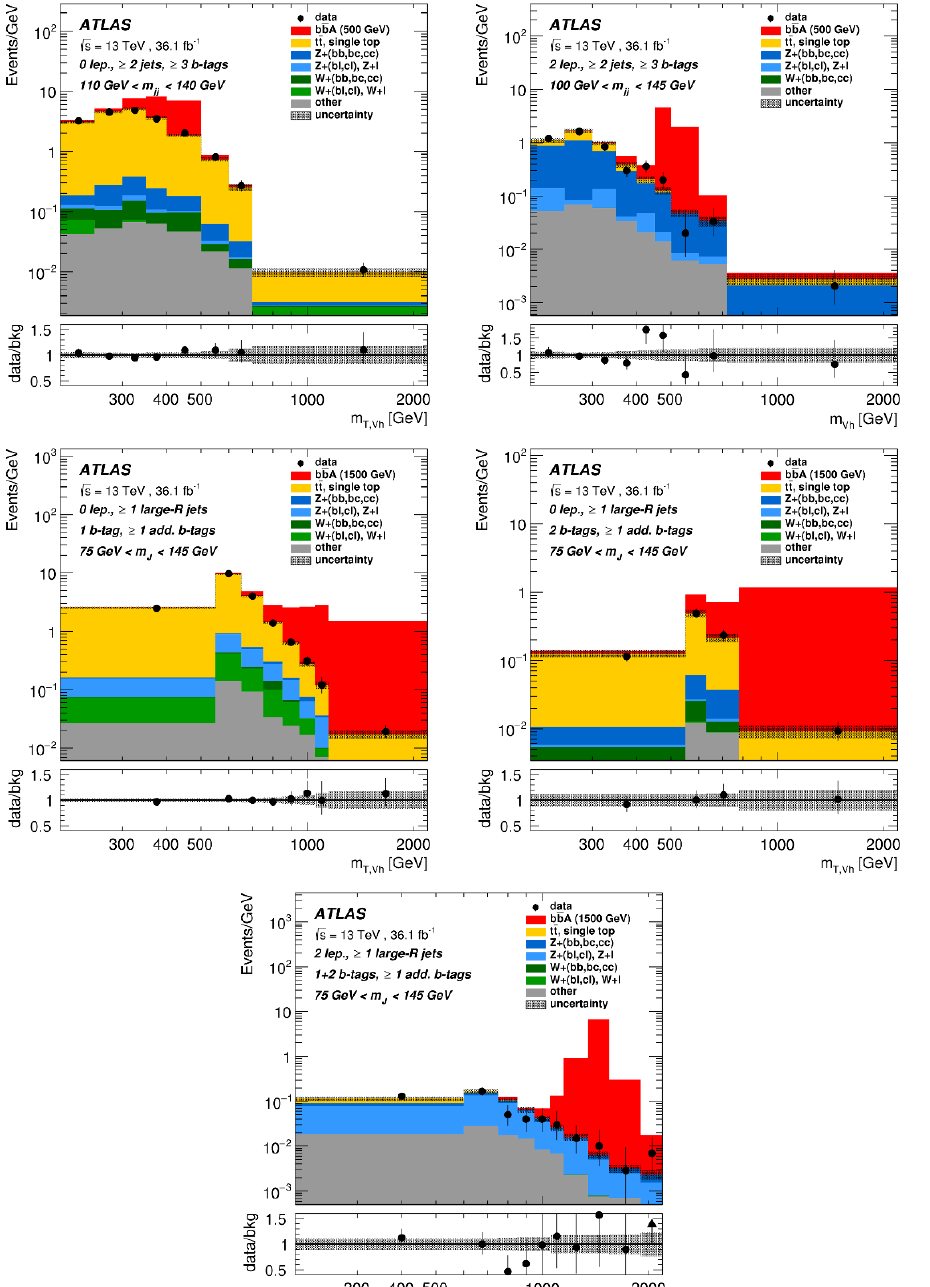
Figure 4. Event distributions of m T ;V h for the 0-lepton channel and m V h for the 2-lepton channel after a background-only (cid:12)t to the categories used in the search for the A boson produced in associa- tion with b -quarks. The quantity on the vertical axis is the number of data events divided by the bin width in GeV. The distribution for an A boson with mass of 500 GeV (1.5 TeV) is shown for illustra- tion in the resolved (merged) regions normalised using a cross-section of 5 pb. The background un- certainty band shown includes both the statistical and systematic uncertainties after the (cid:12)t added in quadrature. The lower panels show the ratio of the observed data to the estimated SM background.